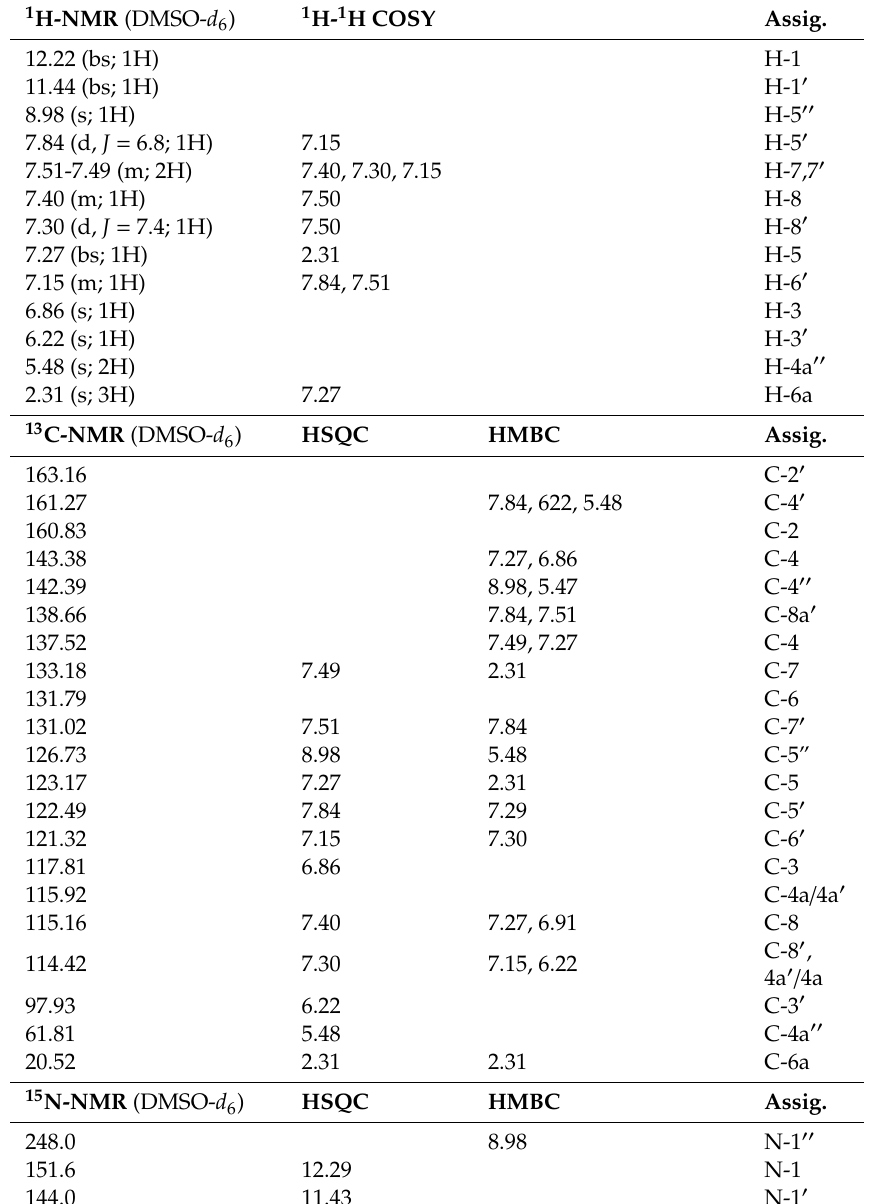
Table 2. NMR data for compound 6b